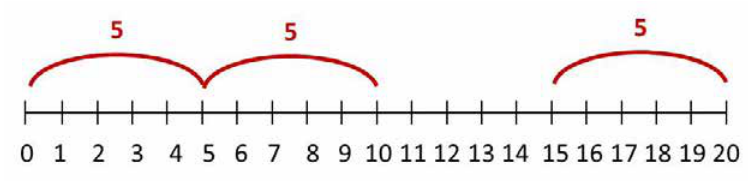
Figure 4: Five symbolises the distance between numbers. With the construction of a number as scale, or distance on the number line, relationships between numbers can also be modelled on the next higher level of abstraction. With this number concept, which Stern (1998) calls the relational number concept, relationships between quantities can be modelled. Comparison problems of the following kind are typically used to assess this relational number concept level: ‘Maria has got 5 marbles. Hans has got 8 marbles. How many marbles has Hans got more than Maria?’ (difference quantity unknown) or ‘Maria has got 4 marbles. She has got 3 marbles less than Hans. How many marbles has Hans got?’ (reference quantity